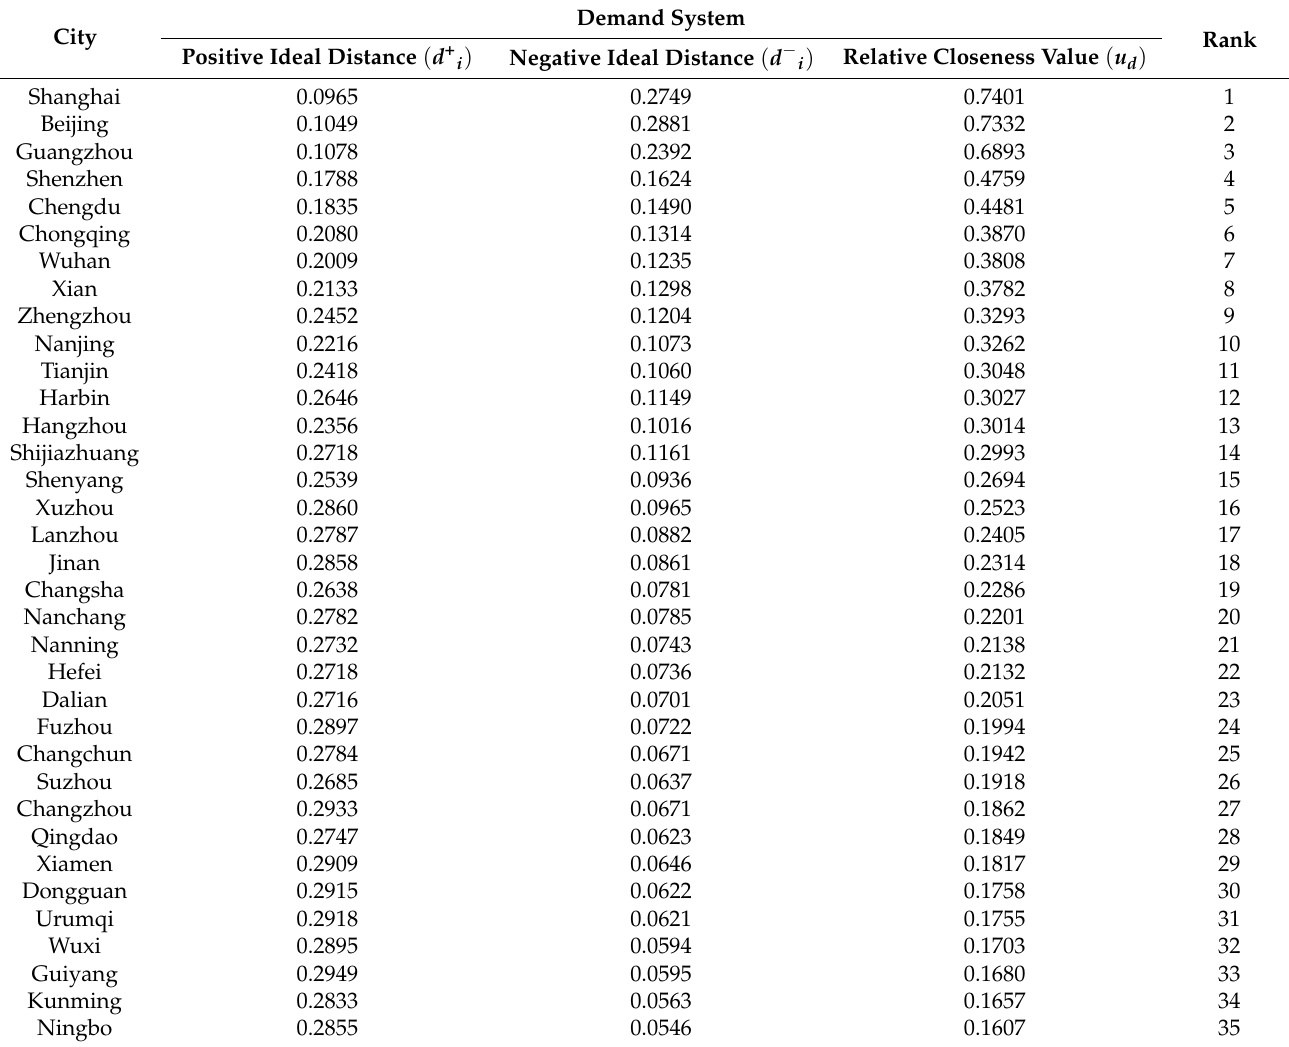
Table 5. TOPSIS values of demand